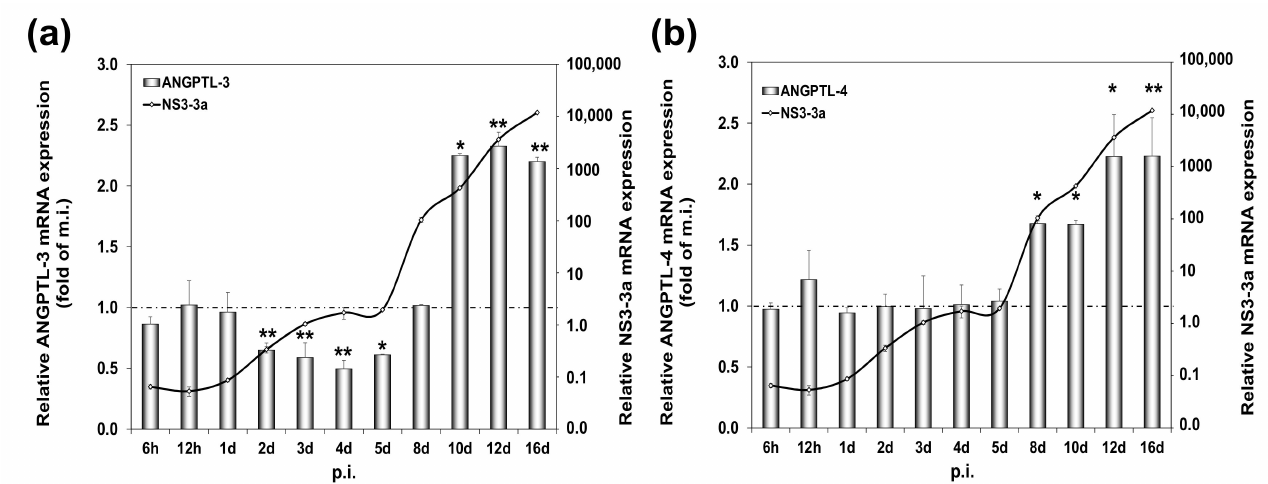
Figure 3. mRNA expression levels of ANGPTL-3 and ANGPTL-4 during long-term HCV infection in vitro. Huh7.5 hepatoma cells infected with HCV-3a were harvested at the stated time points post-infection (p.i.) and subjected to RT-qPCR with ( a ) ANGPTL-3- or ( b ) ANGPTL-4-specific oligonucleotide primers. HCV NS3-3a mRNA expression was used as an indicator of HCV replication (black continuous line on a logarithmic axis). Each bin represents the ratio of the relative mRNA expression in HCV-infected cells to that of the mock-infected control cells (dotted line). Statistically significant differences within groups are denoted by one star ( p -value ≤ 0.05), or two stars ( p -value ≤